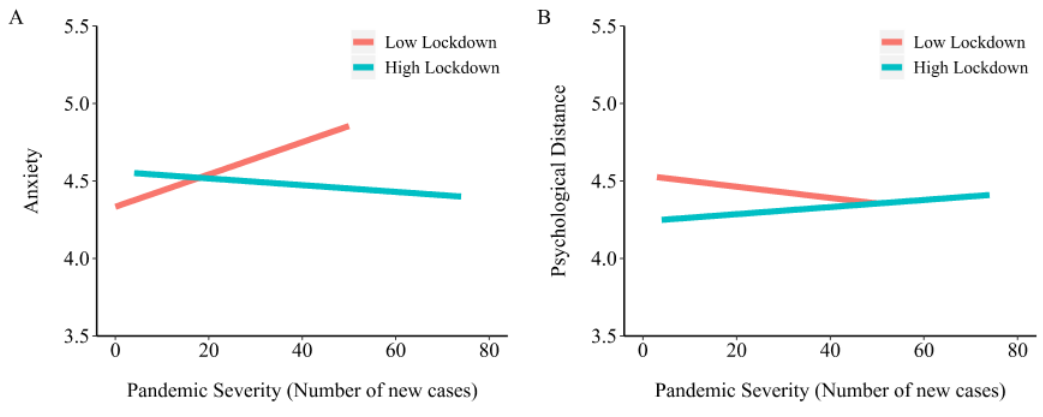
Figure 2. The moderation e ff ect of lockdown on psychological outcomes. ( A ) indicates the moderating e ff ect of lockdown on the relationship between pandemic severity and anxiety; ( B ) indicates the moderating e ff ect of lockdown on the relationship between pandemic severity and psychological distance.